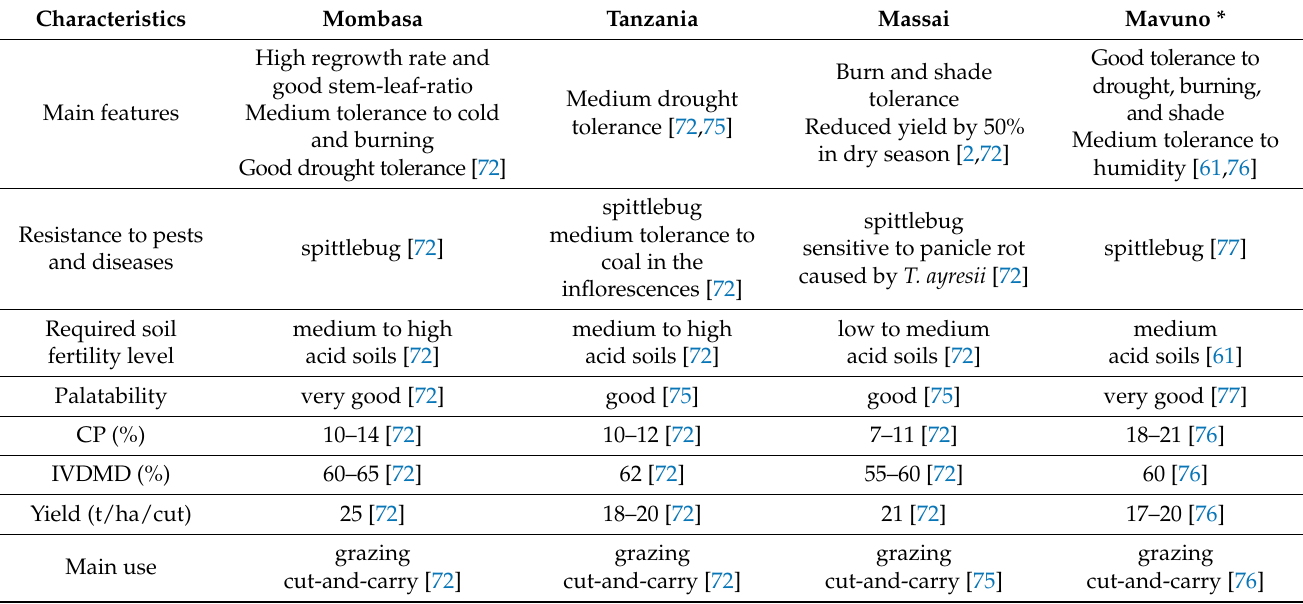
Table 2. Potential competitors for new Megathyrsus maximus